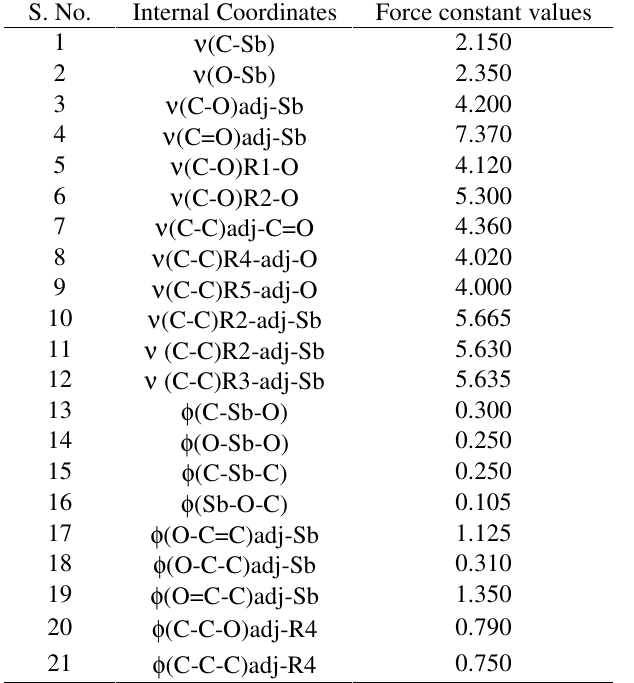
1. Model molecular structure of triphenylantimony(V)- o -salicylate Internal coordinates and force constant values (mdynes/ Ǻ ) of the title compound S. No. Internal